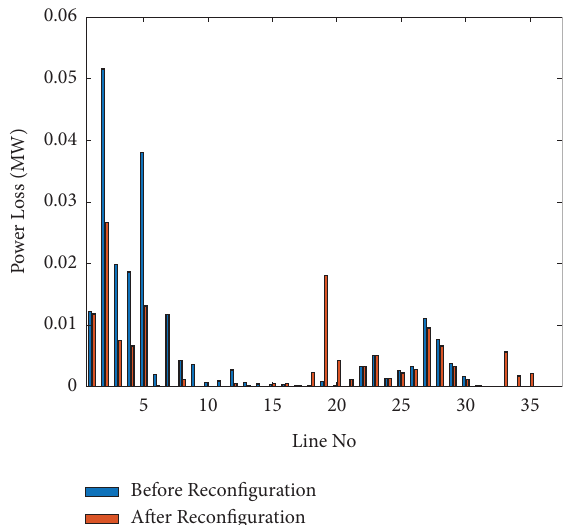
Figure 9: Each line losses in 33-bus system normal load before and after reconfguration.